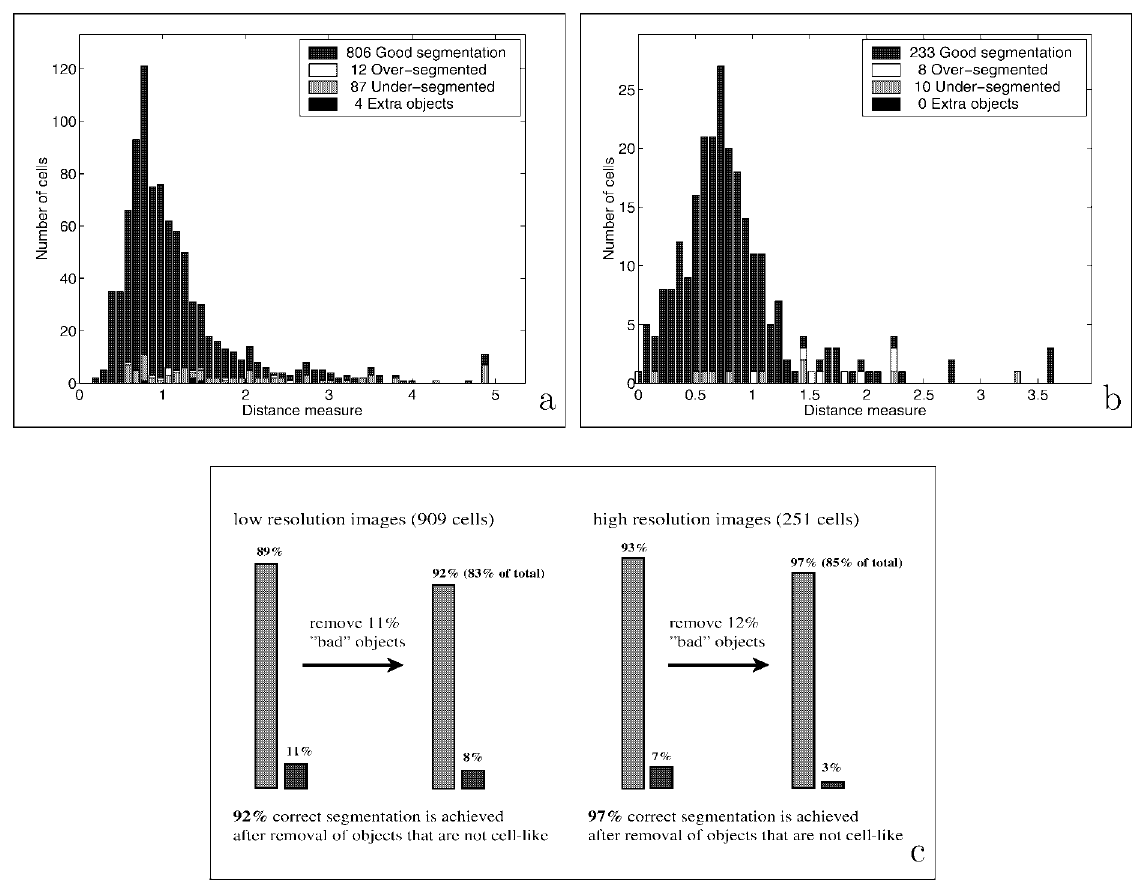
Fig. 8. Histogram of the statistical distance, i.e., inverse of the quality score, of the segmented cells in the low (a) and high (b) resolution images along with a bar plot of the final result of the segmentation algorithm